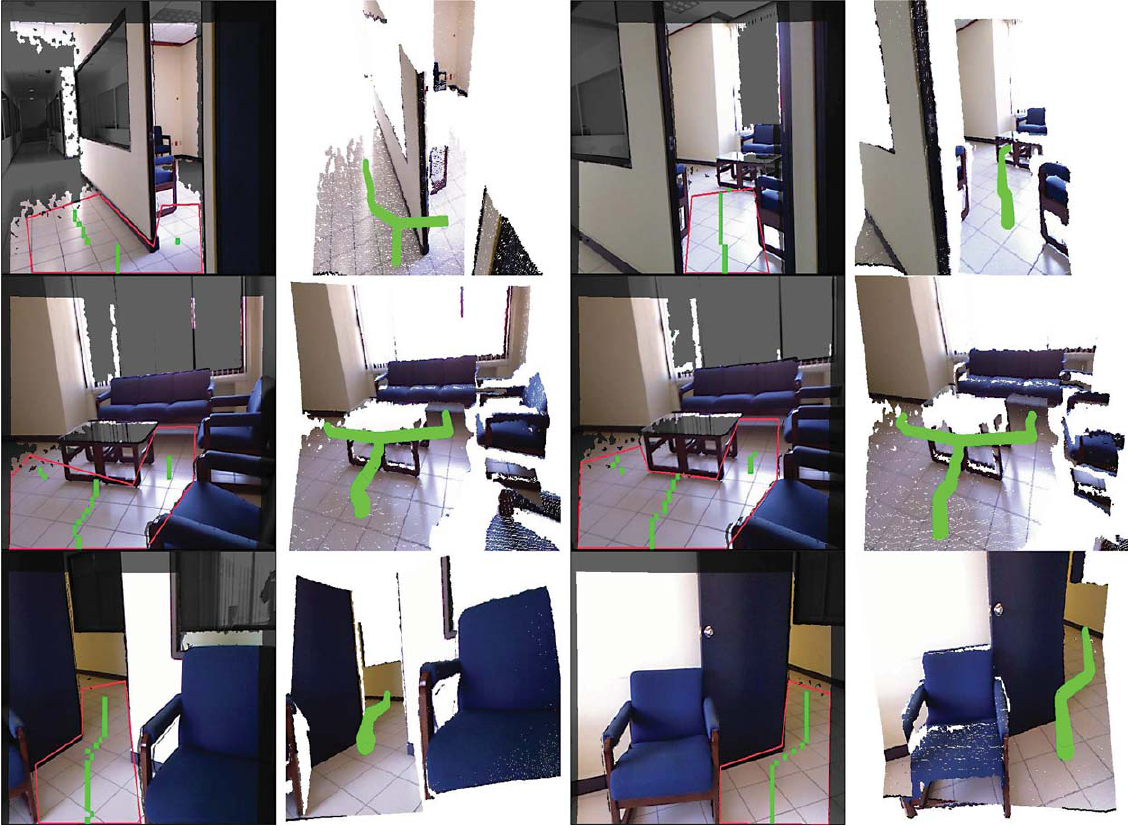
Fig. 22. Sequence of entering and leaving an office: planning paths with detected floor. The path is drawn on the images and on the 3D reconstruction. used when the path is in a big area obstructed by